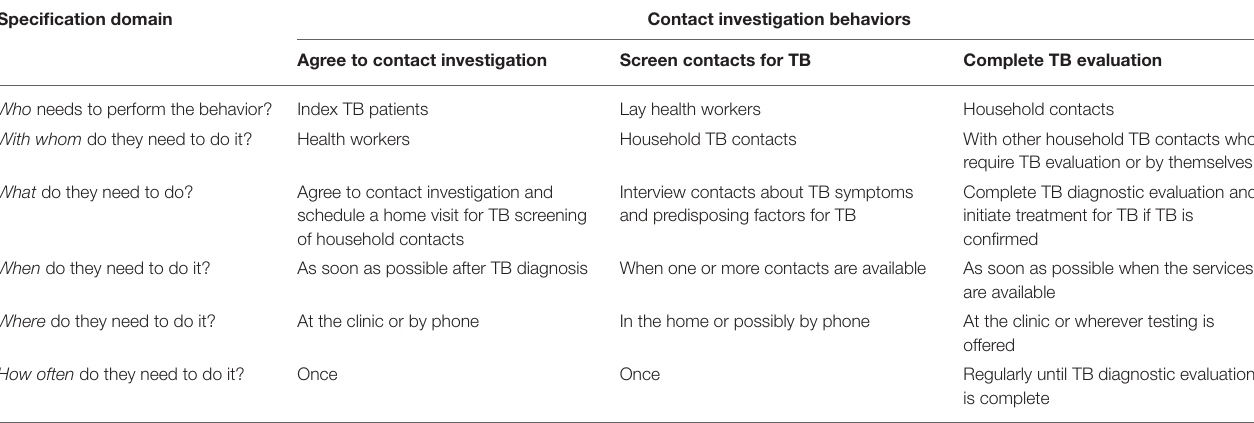
TABLE 1 | Specification of the behaviors required for delivery of household TB contact investigation. Specification